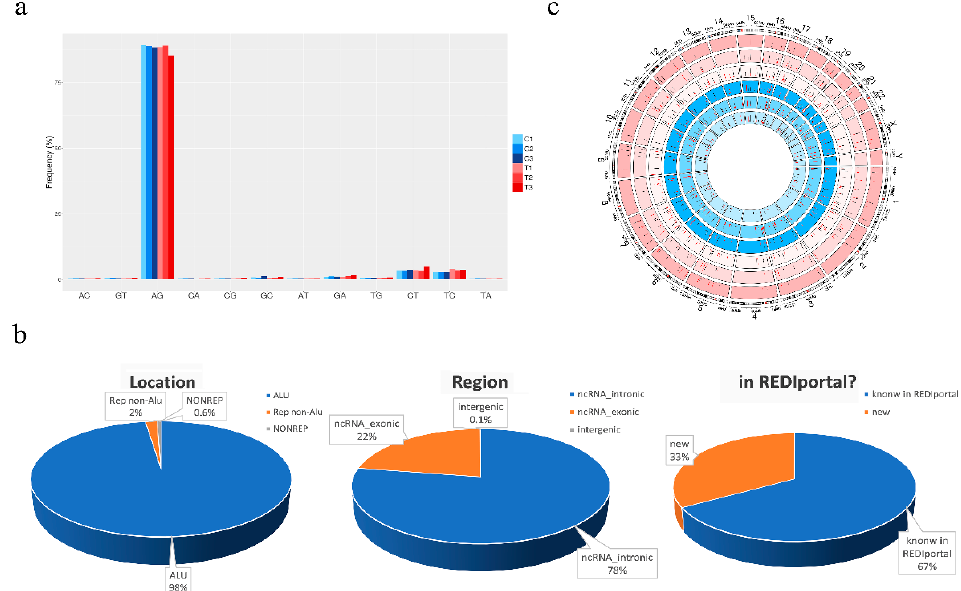
Figure 1. De novo RNA editing detection in long non-coding RNAs. ( a ) Bar graph shows nucleotide changes distribution. The plot indicates that most of the detected RNA editing events were A-to-G. All other changes were rare, with low substitution frequencies showing a high signal-to-noise ratio and specificity of our methodology. C1, C2, and C3 indicate the normal brain samples and T1, T2, and T3 the GBMs. ( b ) Pie charts showing the fraction of A-to-I sites discovered by our computational approach divided according to genomic location, gene region, and the presence or not in the REDIportal database (Table S1). ( c ) Circos plot reporting as black bars the A/G levels (%) distributed for each chromosome with the filter applied for a minimum coverage of 10 reads (data without filters are reported in Table S1). The analyzed samples are shown in concentric circles and ordered showing the three tumor tissues and the normal counterpart from the outside to the inside. Red bars indicate RNA editing sites specific for GBM or normal brain.